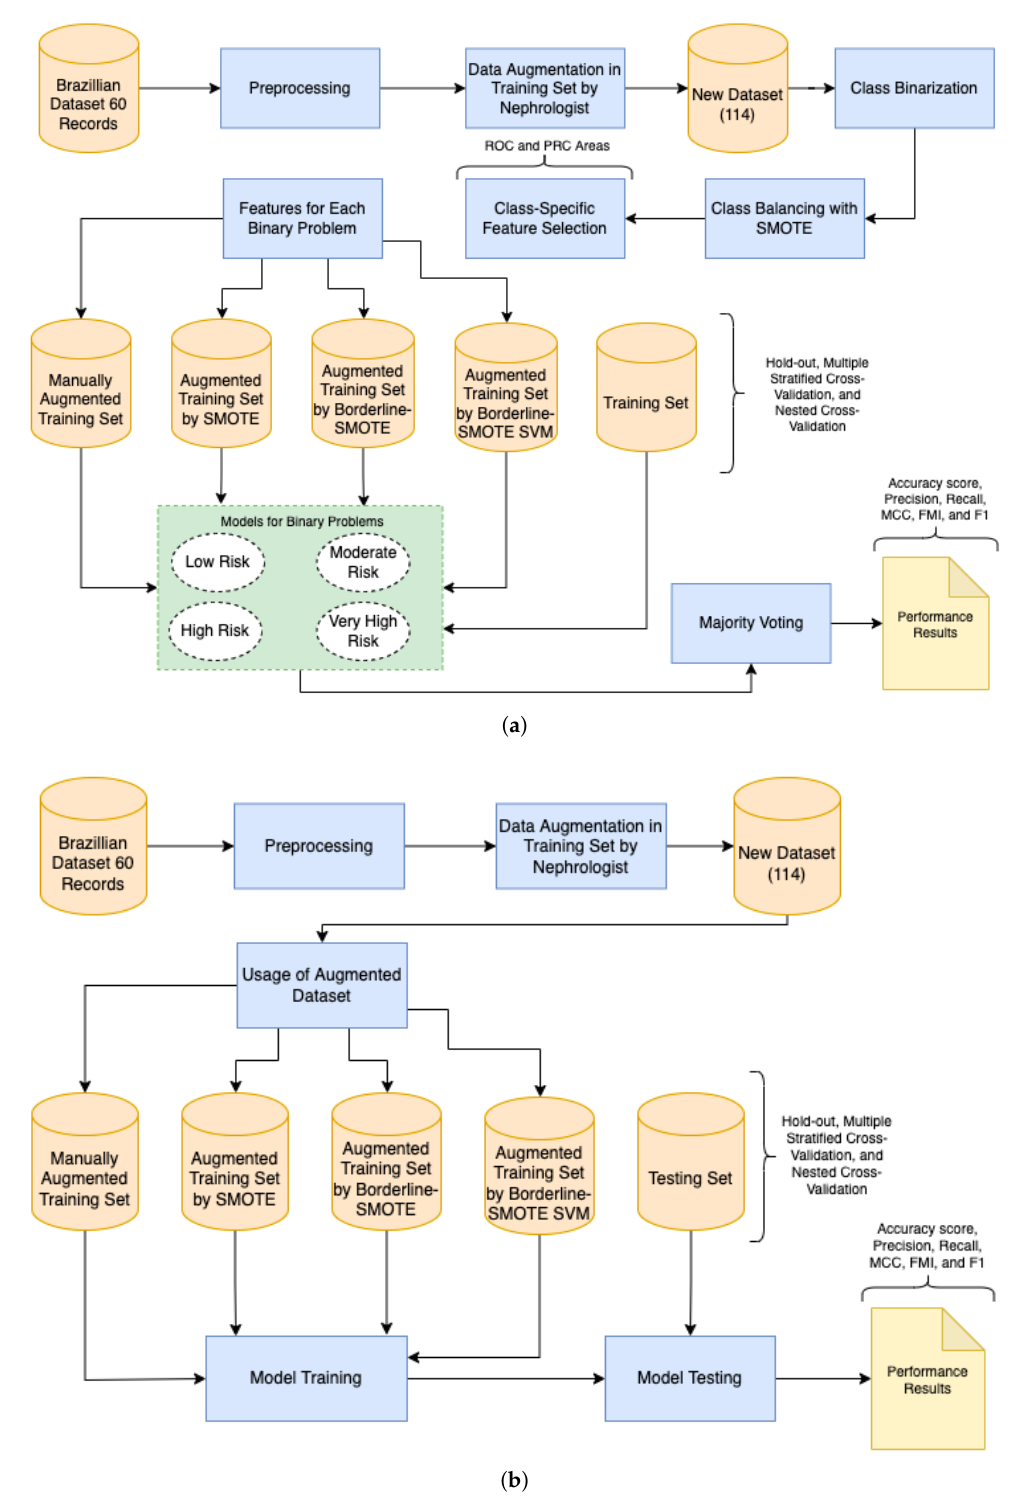
Figure 1. ( a ) Research steps based on the framework proposed by Pineda-Bautista et al. [23]: data preprocessing, model implementation, validation methods, data augmentation, and multi-class classification metrics. ( b ) Research steps based on simple approach: data preprocessing, model implementation, validation methods, data augmentation, and multi-class classification